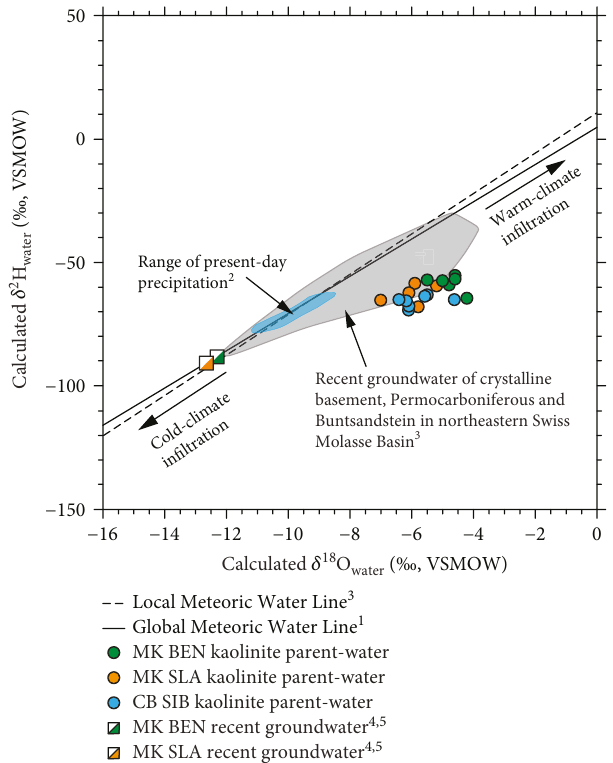
Figure 12: Calculated oxygen and hydrogen isotopic composition of the parent water that precipitated kaolinite and cogenetic calcite in the Muschelkalk (MK) and in the crystalline basement (CB) at the wells of Benken (BEN), Schlattingen (SLA), and Siblingen (SIB). Shown for comparison are the Local and Global Meteoric Water Lines, present-day precipitation, recent groundwater in the Muschelkalk and in the underlying crystalline basement, and Permocarboniferous and Buntsandstein within the NE-Swiss Molasse Basin. 1 [54], 2 [55], 3 [20], 4 [38], 5 this